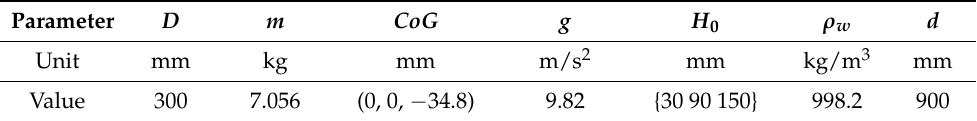
Figure 3. Tested initial submergences and drop heights. The sphere is released, and around eight natural periods in heave should be captured for comparison to the benchmark dataset. The physical parameters of the test case are presented in Table 1. The utilized initial conditions match those of previous tests carried out under the OES working group. Table 1. Values of the test case physical parameters.